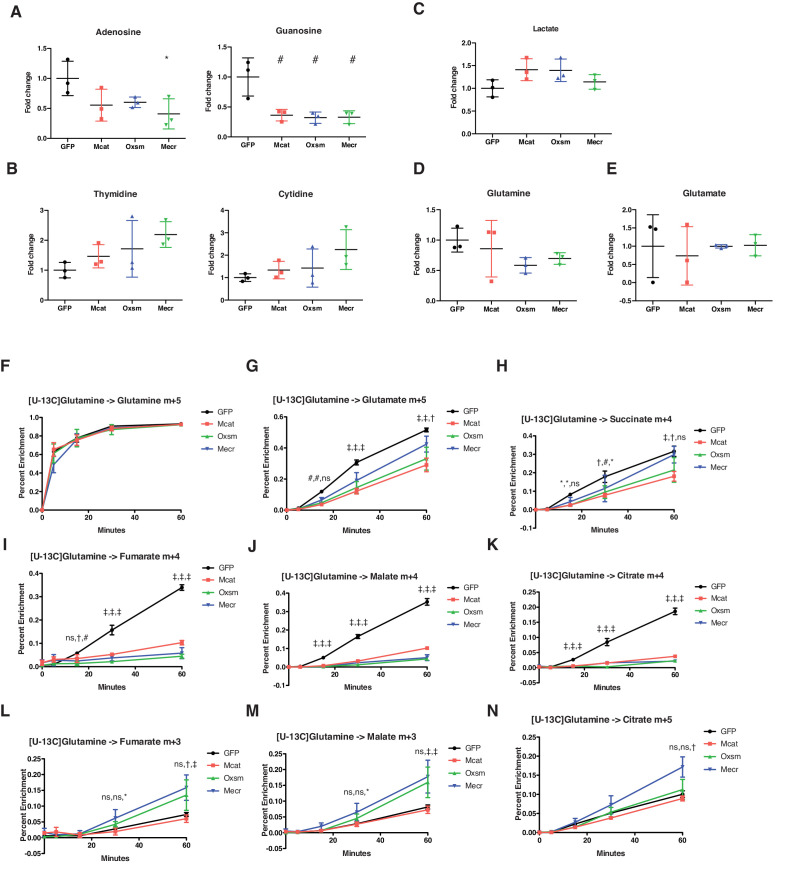
Impairment of mtFAS causes changes in purine abundance and TCA cycle flux.(A–E) Triplicate biological samples from mtFAS mutant cell lines or GFP control were grown under standard proliferative conditions in high glucose media (25 mM) and harvested for steady-state metabolomics analysis by LC-MS. Shown are relative pool sizes for the indicated metabolites. *=p < 0.05, #=p < 0.01, error bars are SD. (F-N) Triplicate biological samples of the indicated genotype were labeled with U13Cglutamine for 5 min, 15 min, 30 min, or 1 hr, harvested, and analyzed via GC-MS for the indicated metabolite isotopologues. *=p < 0.05, #=p < 0.01, †=p < 0.001, ‡=p < 0.0001, error bars are SD. Symbols indicate statistical comparison to GFP control in the order Mcat, Oxsm, Mecr.